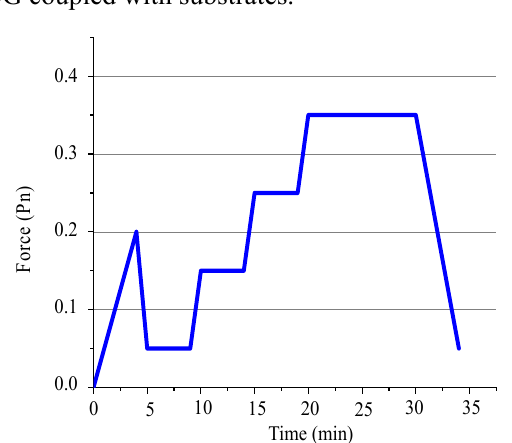
Fig. 5 Pretension profile of the specimens.